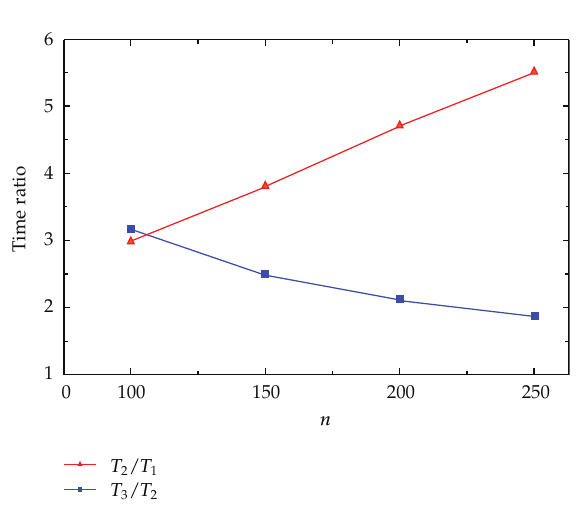
Figure 5: The relation between time ratio and grid